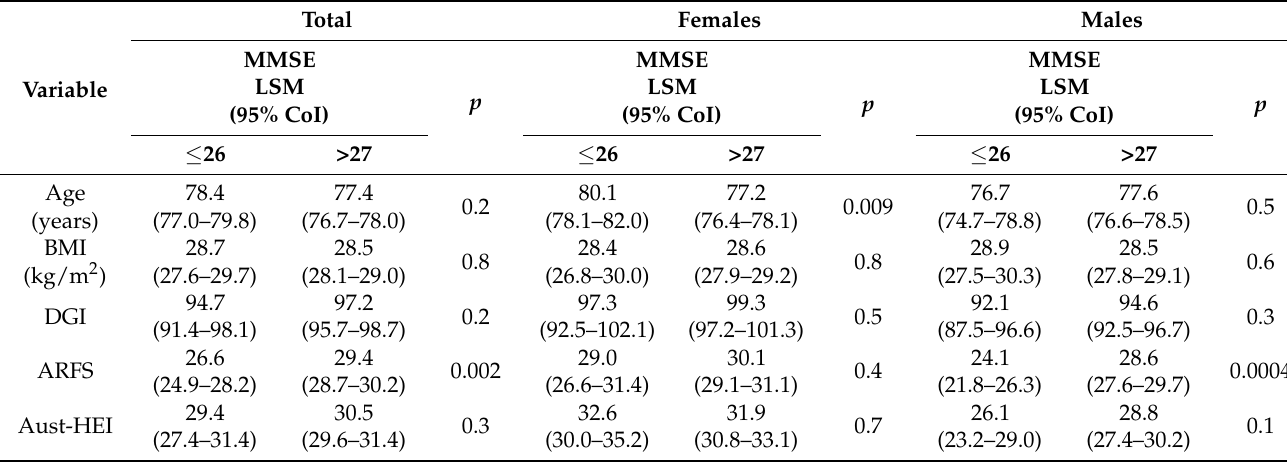
Table 6. Demographic and clinical characteristics by MMSE scores indicative of MCI in the total cohort and by sex (continuous variables).